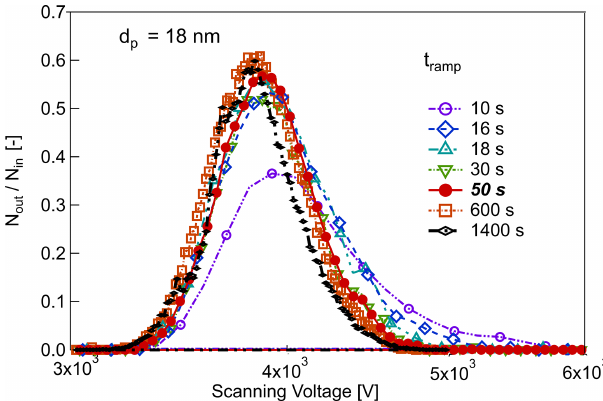
Figure 7. Effect of voltage ramp time, t ramp , on the nSEMS scan- ning transfer function with d p = 18nm input particles. The nSEMS voltage is increased exponentially from 20V to 10kV over ramp times within 10–1400s, including the default t ramp = 50s. CPC smearing of the transfer function increases with decreasing t ramp and becomes very pronounced at t ramp <